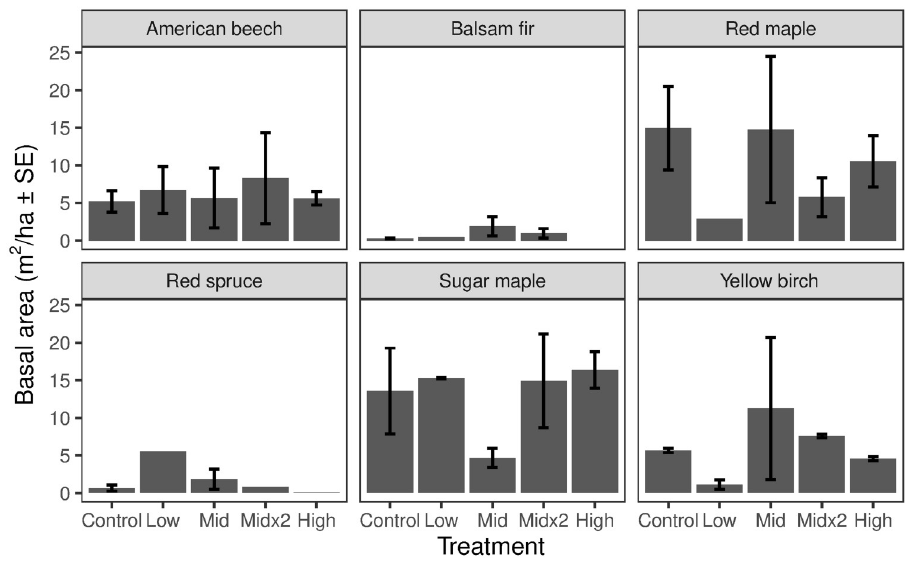
Fig 2. Pre-treatment tree basal area for all trees � 5 cm DBH by species and treatment. Treatments did not differ in mean basal area for any species ( P > 0.05). Vertical lines are ± 1 standard error.